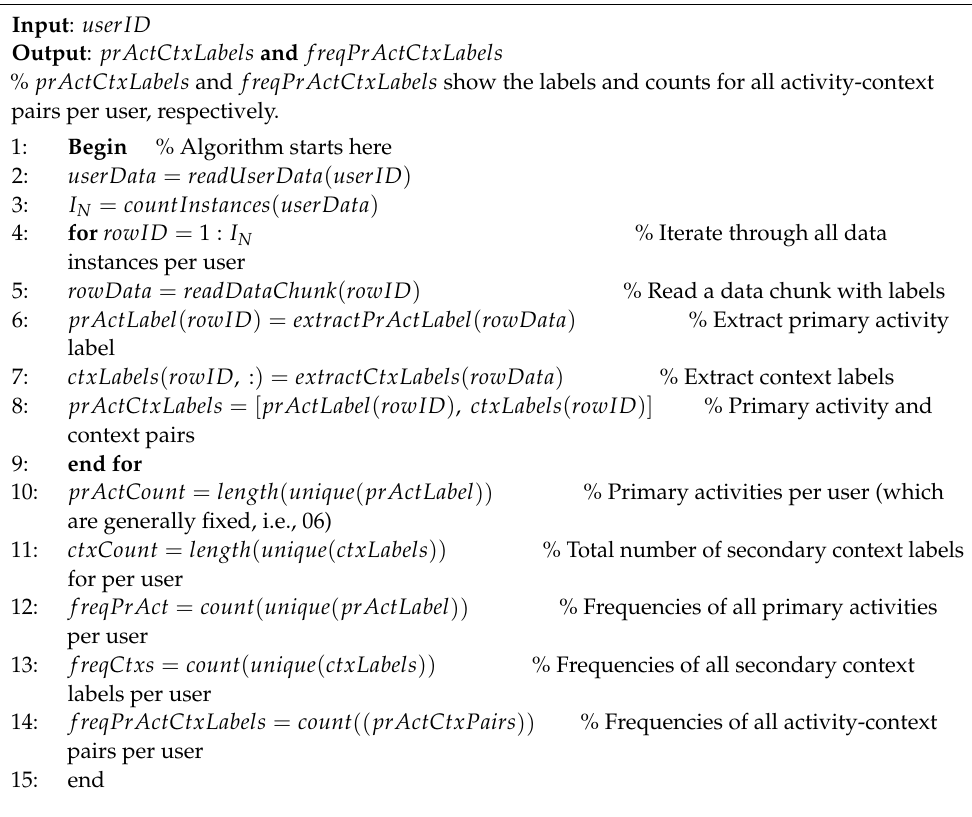
Algorithm 1. Extraction of activity-context pairs and their frequencies per user for